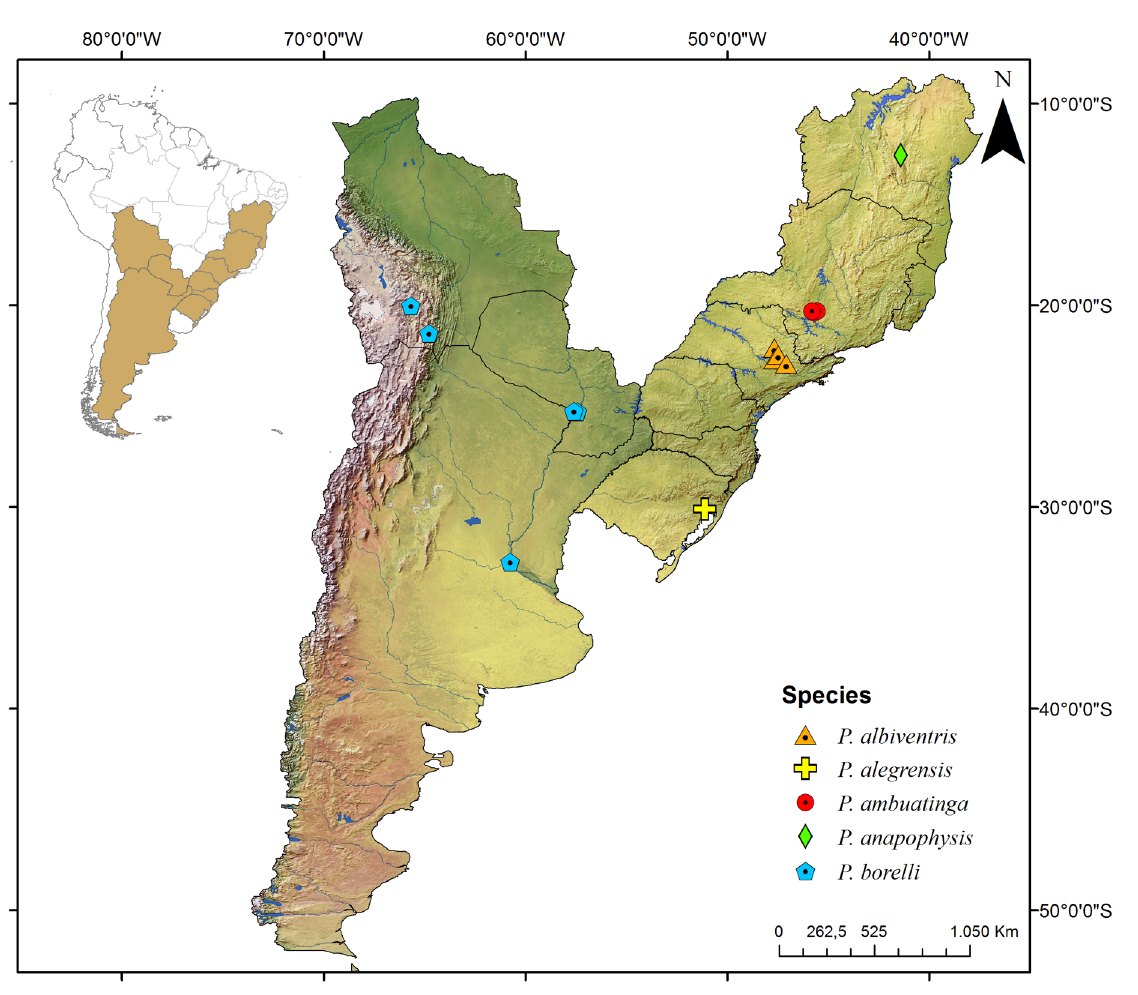
Fig. 180. Distribution map of the species Pseudonannolene albiventris Schubart, 1952, P. alegrensis Silvestri, 1897, P. ambuatinga Iniesta & Ferreira, 2013, P. anapophysis Fontanetti, 1996, and P.